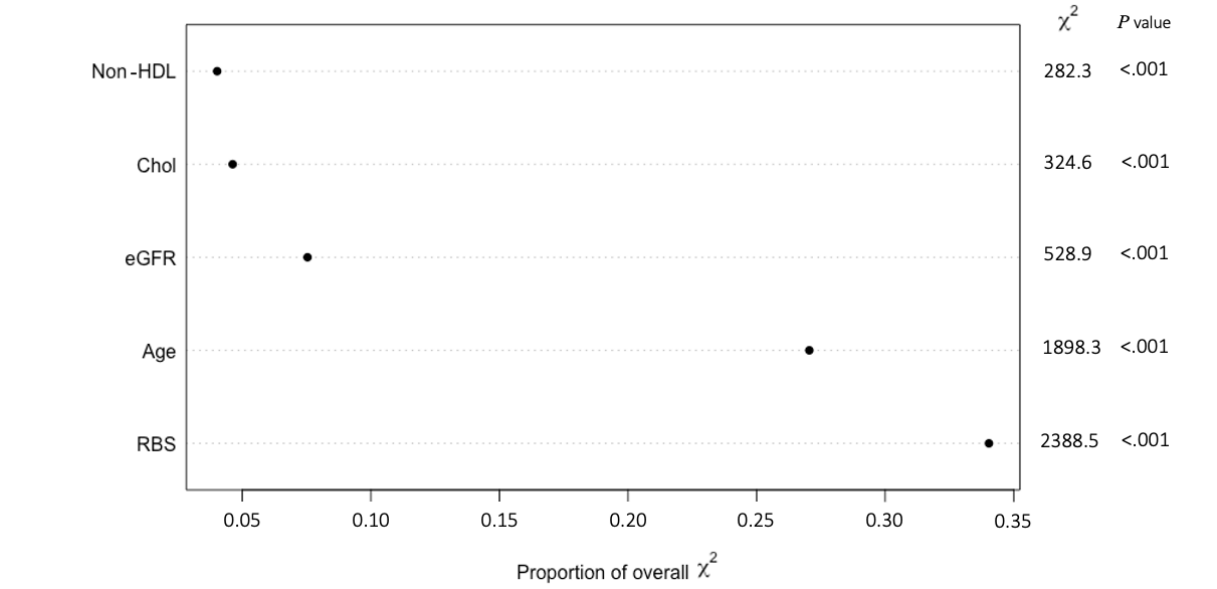
Figure 5. Order of importance of predictors for PM3. Chol: cholesterol. eGFR: estimated glomerular filtration rate. HDL: high-density lipoproteins. PM: predictive model. RBS: random blood